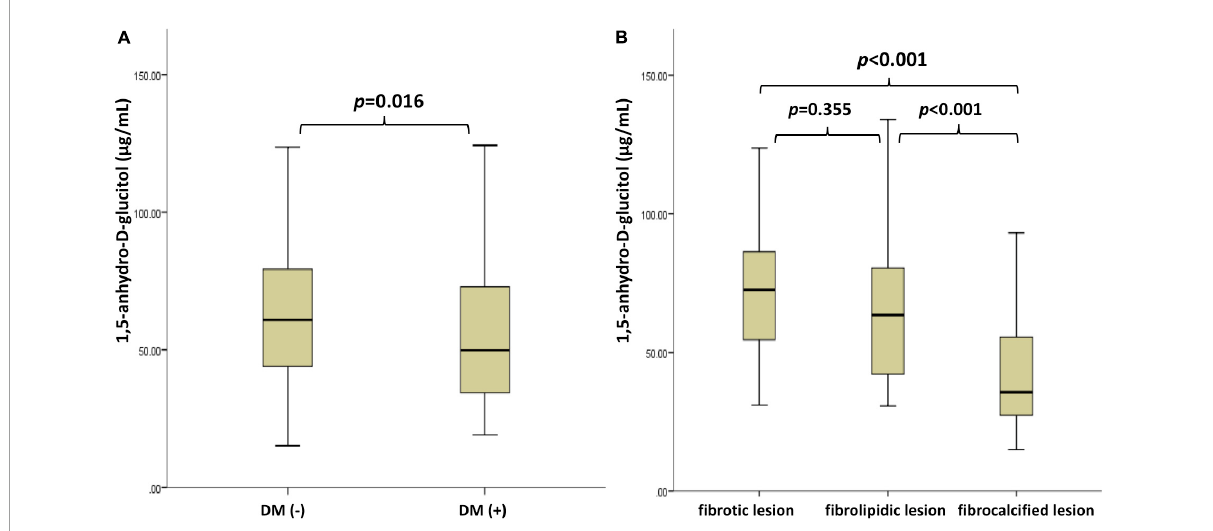
FIGURE2 Serum 1,5-AG levels were stratified by DM and plaque characteristics. p -values by analysis of variance (ANOVA and Chi-square) were shown. Post hoc comparisons were performed by the Bonferroni test. (A) Serum 1,5-AG level was significantly lower in DM patients than in non-DM patients (DM vs. non-DM: 55.6 ± 27.9 µ g/mL vs. 63.7 ± 26.1 µ g/mL, p = 0.016). (B) Serum 1,5-AG levels were significantly lower in fibrocalcified lesions than in fibrotic or fibrolipidic lesions (fibrocalcified vs. fibrotic or fibrolipidic: 42.8 ± 19.1 vs. 72.9 ± 25.2 or 66.4 ± 27.5 µ g/mL, p < 0.001). 1,5-AG, 1,5-anhydro-D-glucitol, DM, diabetes